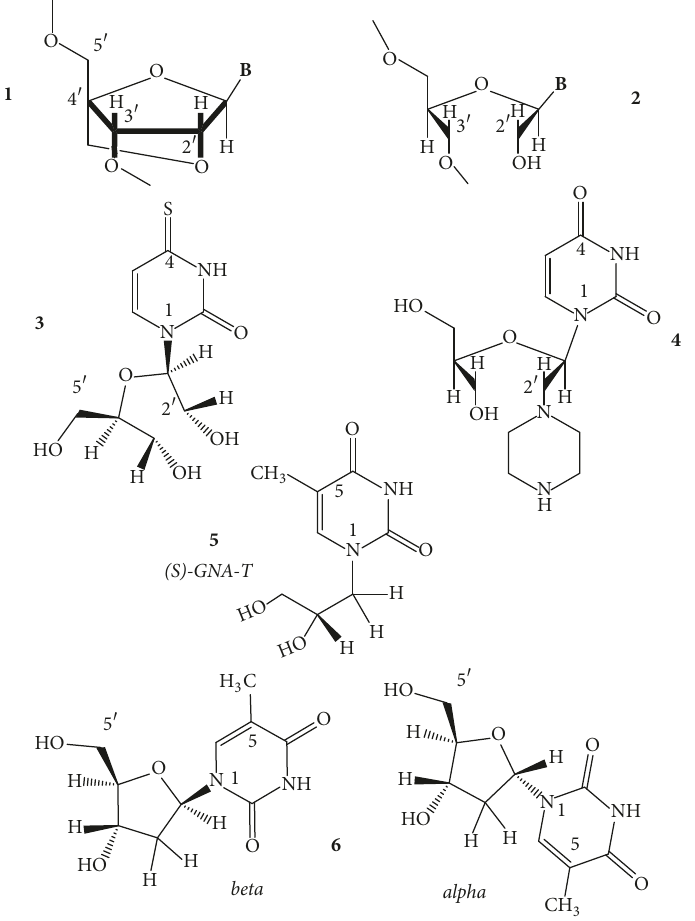
Figure 10: Structures of the locked nucleoside 2 󸀠 -O-4 󸀠 -C-methylene-guanosine (LNA), where B stands for a nucleobase ( 1 ); the unlocked nucleoside 2 󸀠 -3 󸀠 -acyclic-ribonucleotide (UNA) ( 2 ); 4-thio-unlocked-uridine ( 3 ); 2 󸀠 -C-piperazino-unlocked-uridine ( 4 ); an acyclic thymine derivative, (S)-GNA-T ( 5 ); and the beta- and alpha-thymidines ( 6